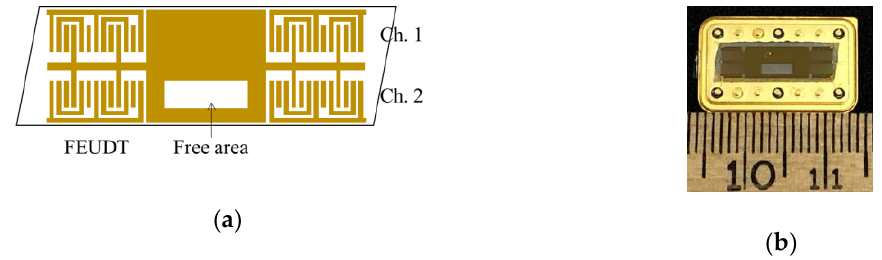
Figure 1. ( a ) Schematic illustration and ( b ) photograph of the shear horizontal surface acoustic wave (SH-SAW) sensor used.